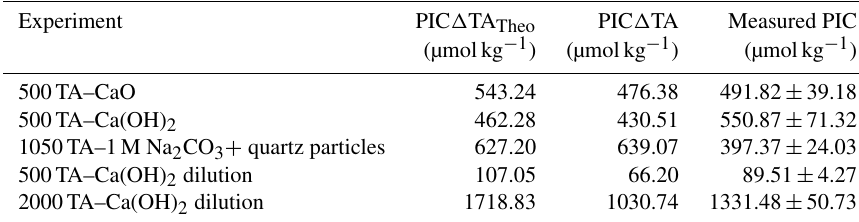
Table 2. Comparison between the estimated particulate inorganic carbon (PIC) based on half the TA change between the theoretical maximum TA increase upon full dissolution of the alkaline material added and the measured TA at the end of the experiment (Table 1), the estimated PIC based on half the TA changes between the measured maximum TA increase and the measured TA at the end of the experiment, and the measured PIC from the particulate carbon